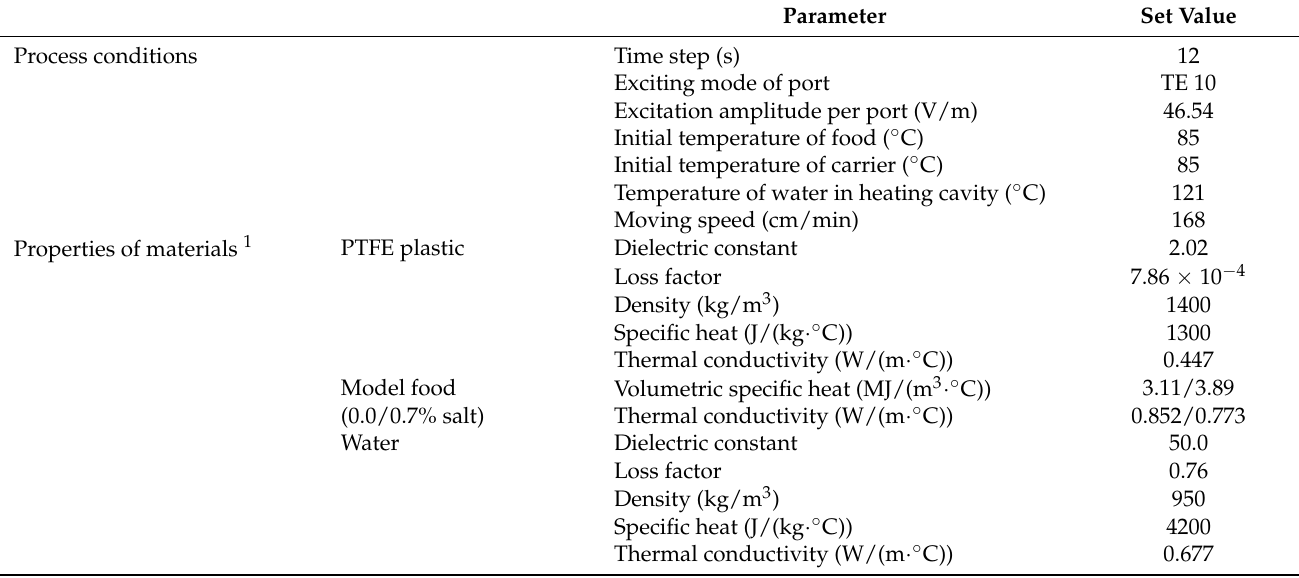
Table 1. Simulation settings for the microwave-assisted thermal sterilization (MATS)